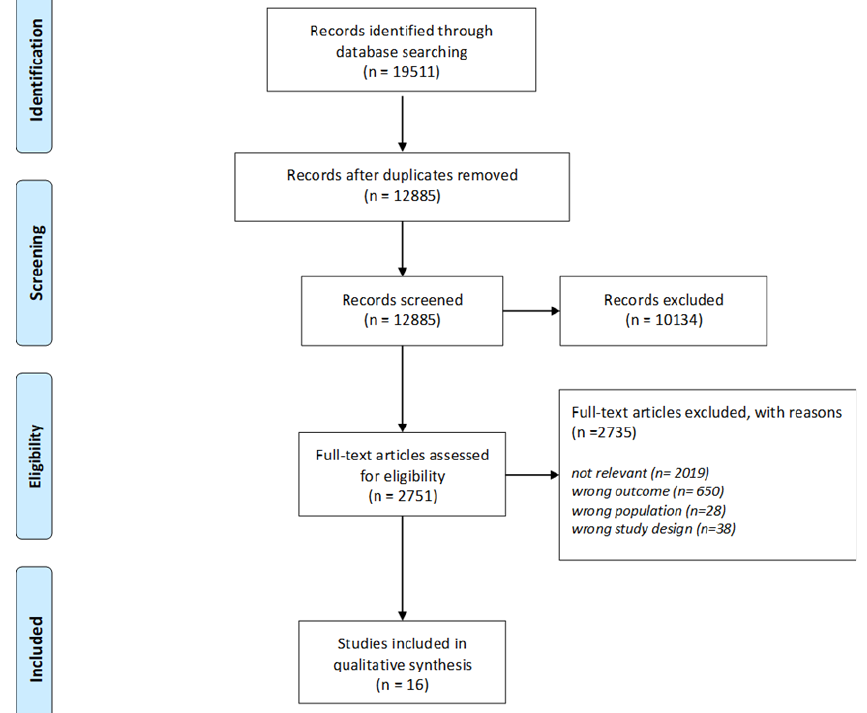
Figure 1. Flow diagram of the study selection process.